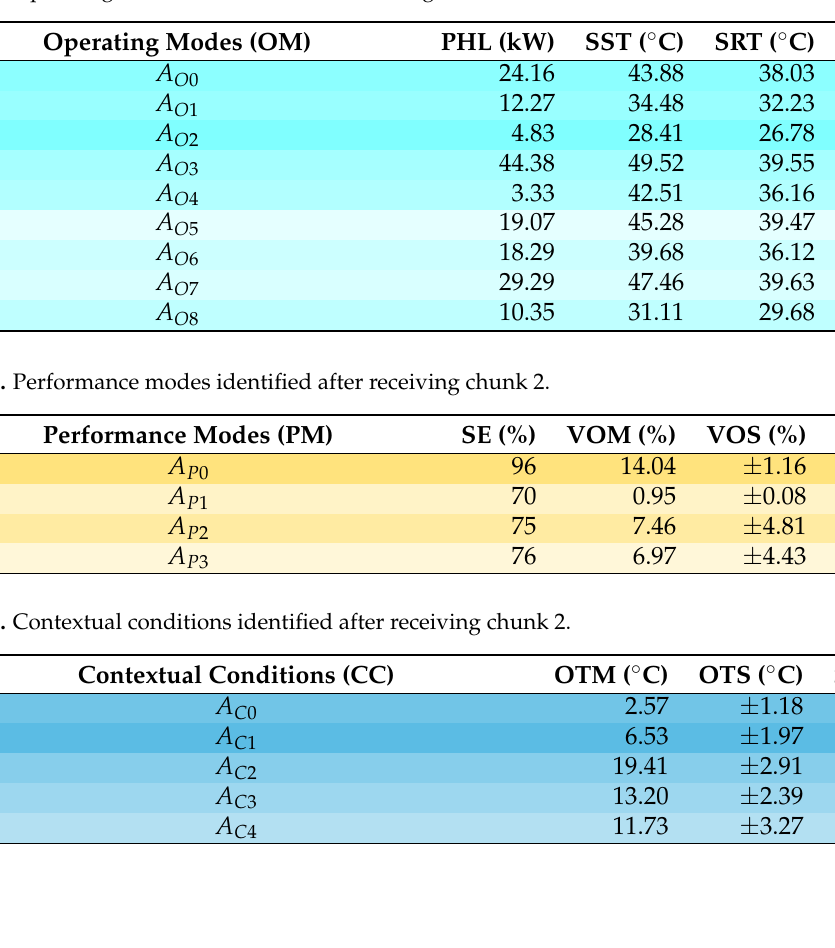
Table 3. Operating modes identified after receiving chunk 2.